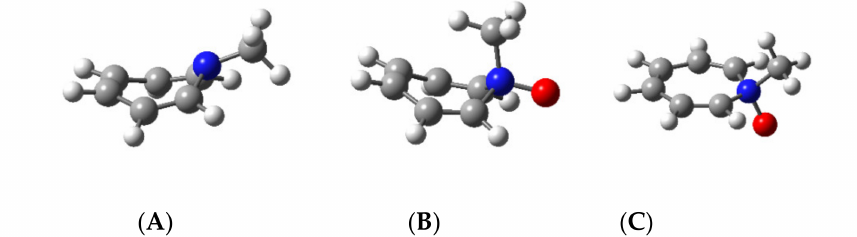
Figure 2. Calculated structures for ( A ) most stable conformation of N -methylazepine, ( B ) most stable conformation of N -methylazepine N -oxide, ( C ) fully planar ring structure of N -methylazepine N